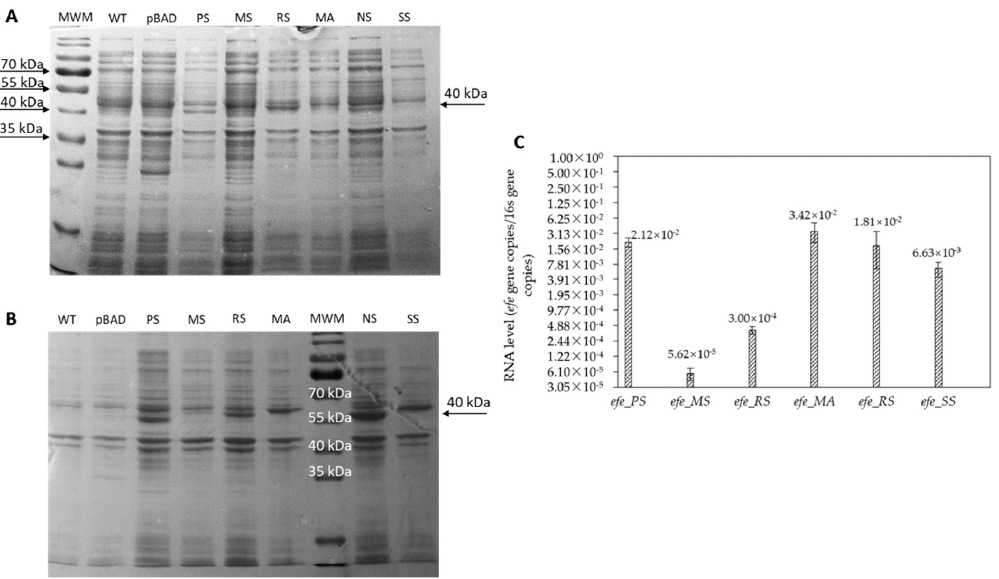
Figure 5. Heterologous expression of the six Efe strains. ( A ) SDS ‐ PAGE of crude extract in supernatant, ( B ) SDS ‐ PAGE of crude extract in insoluble fraction: MWM: protein ladder; WT: BL21 wild type; pBAD: BL21 with pBAD vector; PS: Efe_PS, 39.8 kDa, 12.7% proportion of target protein of crude extract supernatant; MS: Efe_MS, 41.0 kDa, take 5.6% proportion; RS: Efe_RS, 39.6